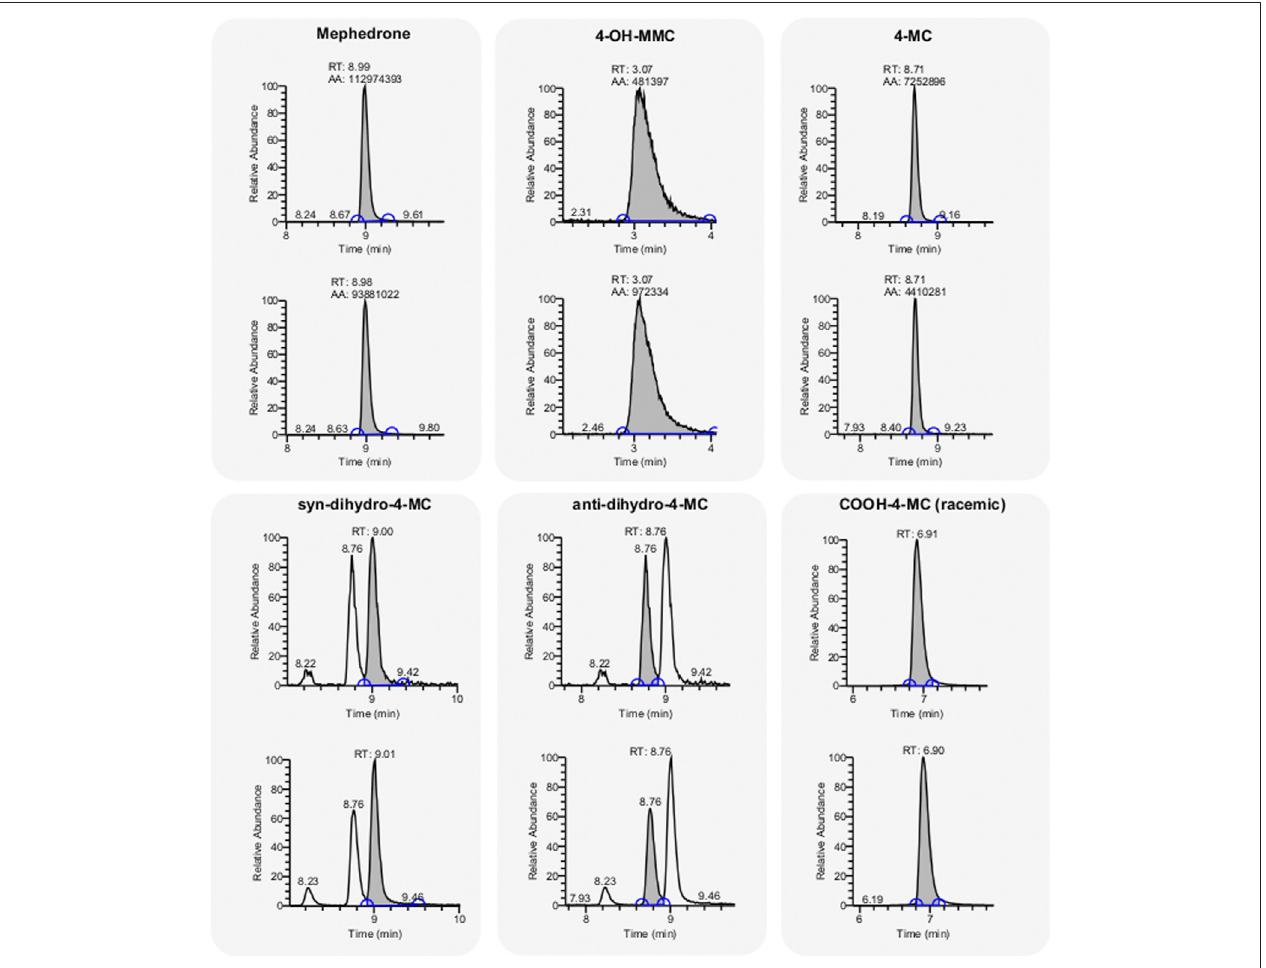
FIGURE 6 | Detection of MEPH metabolites in a human urine sample. Chromatograms of Mephedrone and the detected metabolites (4-OH-MMC, 4-MC, 4-COOH-MC, dihydro-4-MC (anti and syn). The analysis was repeated two times obtaining similar results (grey background, top and bottom).